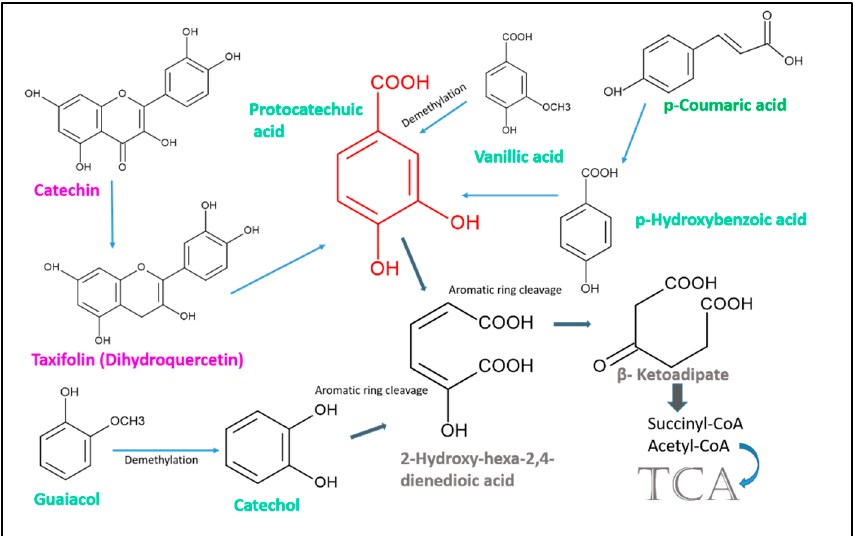
Figure 4. Some steps of the microbial degradation of catechin and taxifolin as members of the flavonoids (magenta), p-coumaric acid, a cinnamic acid derivative (green), and several simple phenolic compounds (petrol). Many phenolic compounds are degraded via the central intermediate protocatechuic acid, and others via catechol. Catechol and protocatechuic acid (red structure) undergo either ortho- or meta- cleavage of the aromatic ring, resulting in 2-hydroxy-hexa-2,4-dienedioic acid and β -ketoadipate. These compounds are converted to succinyl-CoA and acetyl-CoA for entering the citrate cycle